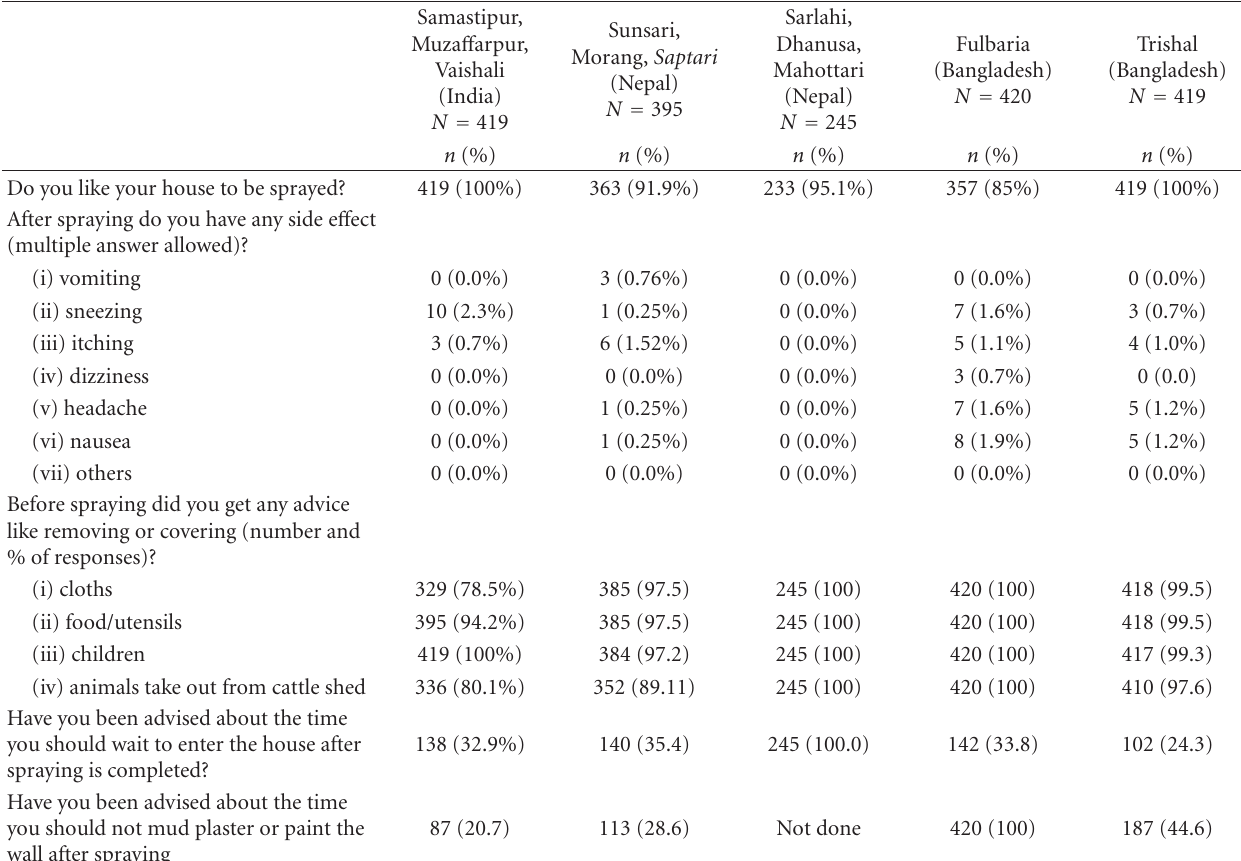
Table 4: Findings of output indicators: IRS acceptability at community